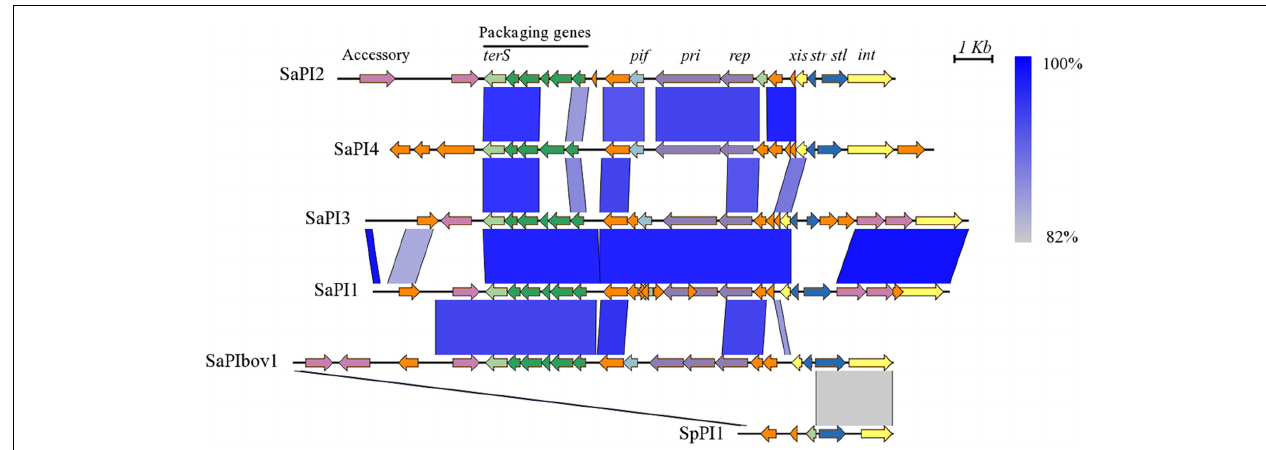
as described previously (Novick et al., 2010): int (integrase) and xis (excisionase) in yellow; transcription regulators in dark blue; replication genes including the primase gene, pri , and the replication initiator gene, rep in purple; encapsidation genes in green; terminase small subunit gene ( terS ) in light green; superantigen and other accessory genes in pink; pif (related to phage interference) in light blue; and genes encoding hypothetical proteins in orange. Figure produced with EasyFig (Sullivan et al.,